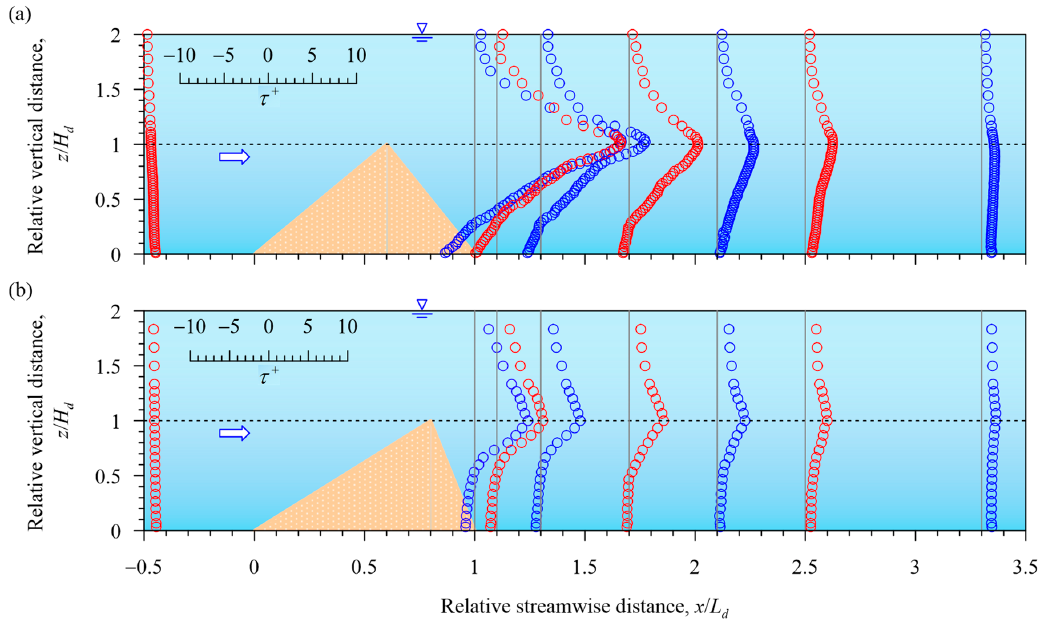
Figure 6. Vertical profiles of nondimensional Reynolds shear stress τ + at the upstream and various downstream relative streamwise distances x / L d of isolated dunal bedforms for ( a ) Run 1 and ( b ) Run